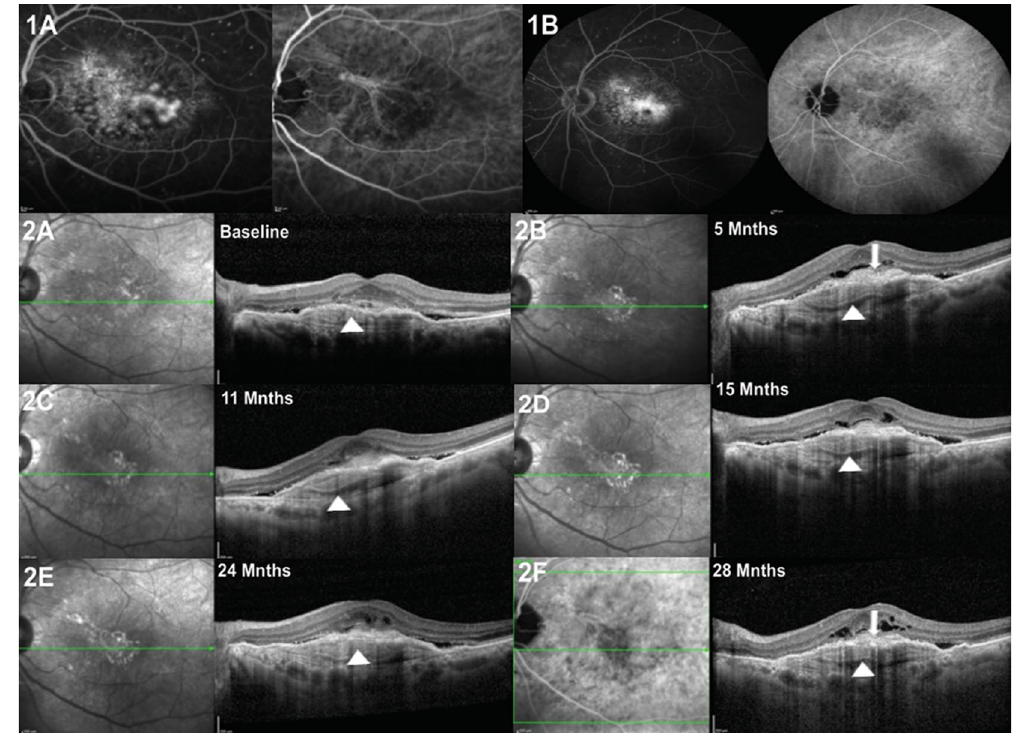
Figure 1. Left eye of a 65-year-old male with neovascular age-related macular degeneration (nAMD), and denovo multilayered pigment epithelial detachment (DN-MLPED). Fundus fluorescein angiography (FFA) shows occult choroidal neovascular membrane (CNVM) with a classic component and a well-defined neovascular network with feeder vessel on indocyanine green angiography (ICGA; A ). Serial cross-sectional optical coherence tomography (OCT) images over 28 months demonstrate the onset and persistence of subretinal hyperreflective material (SHRM; arrows) along with multilayering (Arrowheads) ( A – F